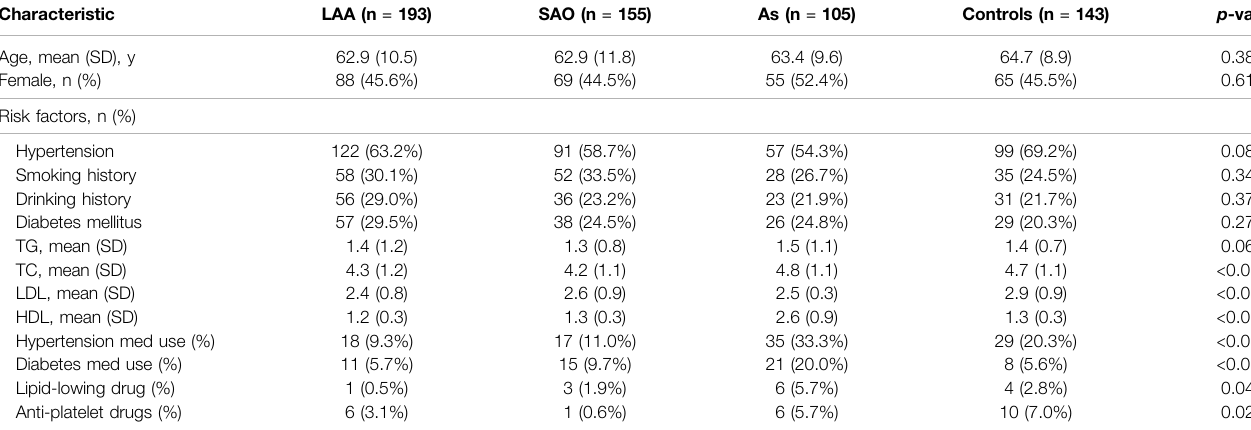
TABLE 1 | Demographic and clinical characteristics of the subjects. ( TG, triglycerides; TC, total cholesterol; LDL, low-density lipoprotein; HDL, low-density lipoprotein). Characteristic